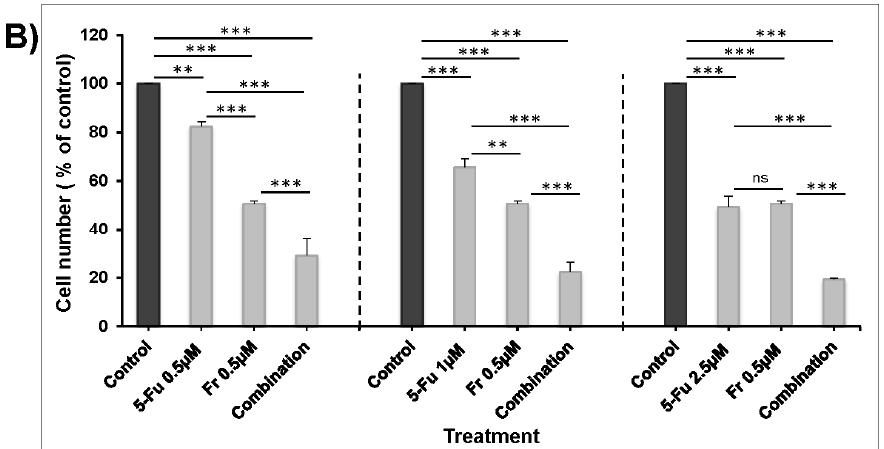
Figure 2. Frondoside A enhances the inhibition of HT-29 cell numbers by ( A ) oxaliplatin (1–10 µM), and ( B ) 5-fluorouracil (0.5–2.5 µM). Cells were treated for 48 h, and all experiments were repeated at least three times. Columns are means; bars are S.E.M. ** Significantly different at p < 0.01. *** Significantly different at p < 0.001. ns (not significant).